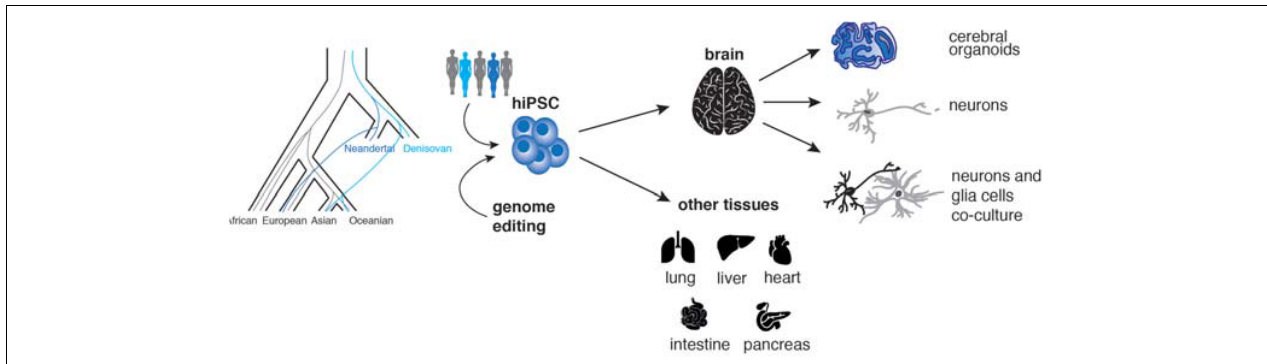
FIGURE 2 | Addressing the neurobiology of recent human history using iPSCs. Human pluripotent stem cells (iPSCs) carrying natural or introduced (via CRISPR-Cas9 genome editing) Neandertal or Denisovan ancestry can be differentiated into various 2D-cell systems and 3D-organoids types to generate “ancestralized” cells and tissues like brain, lung, liver, heart, pancreas, and intestine (Dannemann et al., 2020).